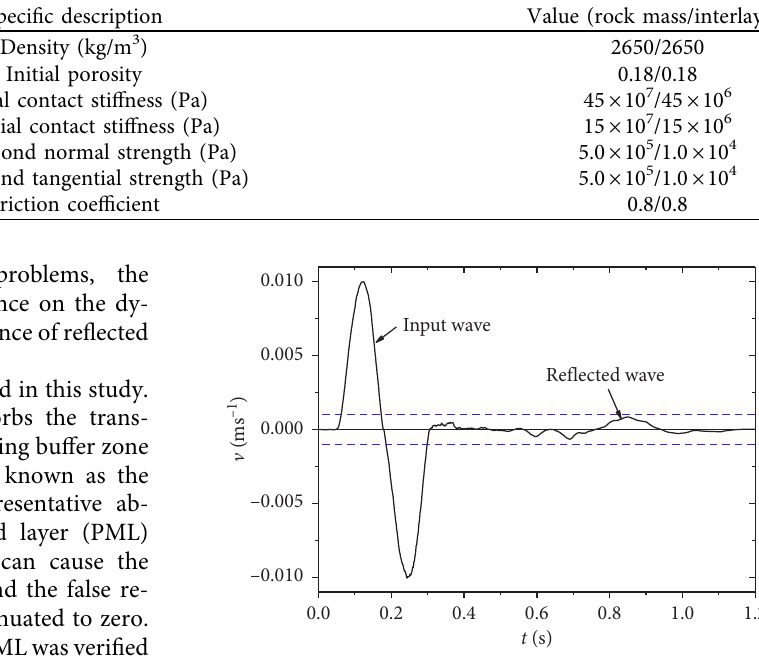
Figure 17: Schematic of the calculation model and PFC2D model. Table 2: Mesoscopic parameters of the DEM model.